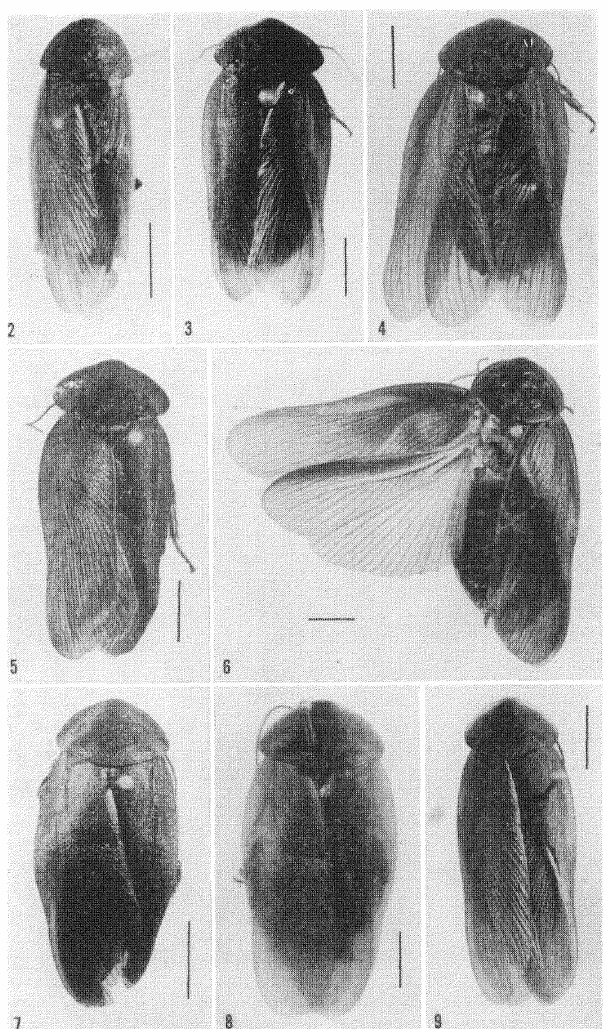
Figures 2-9. Adult males of Perislhaeria spp. 2. (1424 L). P. virescens (Brunner). (det. Prineis). 3. (40 CUZM). P. scabra (Thunb.). Cap bono Spei, Dee. 1816. 4. (1420 L). P. scabra. Holub, South Africa (det. Prineis). 5. (1419 L). P. saxicola (Eseh.) Capetown, Table Mountain, 2400’ (det. Princis). 6. (1422 L). P. rulqcornis (Sauss. and Zehn.). Swart- bergpas, Platberg, Cape Province, South A/riea, ca. 5000’ (det. Prineis). 7. (1421 L). P. stylifera Burro. Manhiea (det. Prineis). 8. (161 ANSP). P. stylifera. Durban. (det. by Rehn as Hylosphaeria giebeliana (Sauss. and Zehn.). 9. (1423 L). P. asera (Walker). Baberton, Levetzow (det. Prineis). (scale---